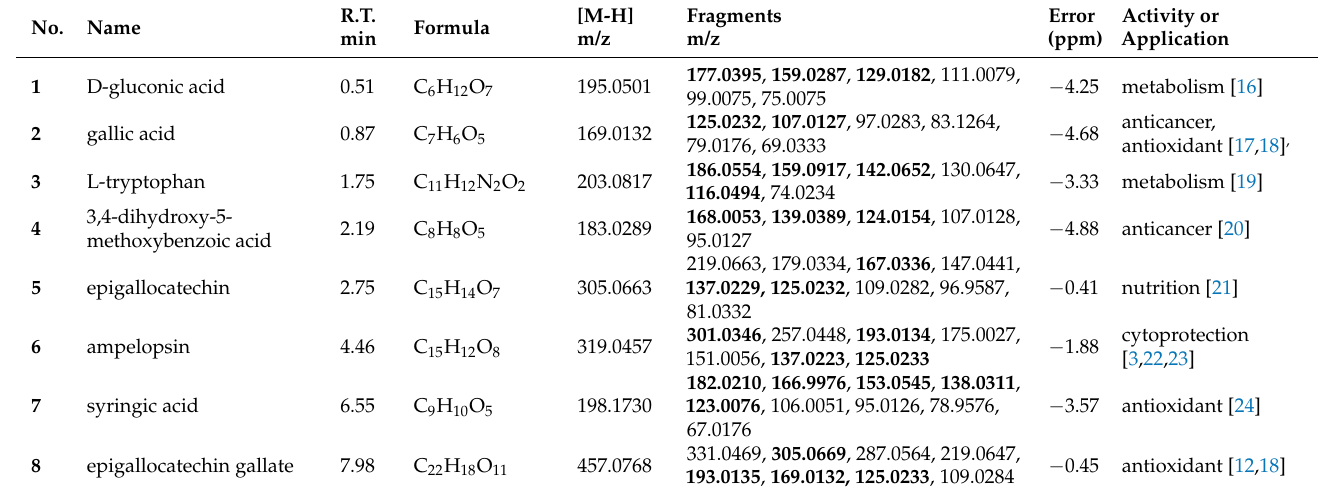
Figure 2. The total ion chromatogram (TIC) of vine tea in the UPLC-Q-Orbitrap-MS analysis. Table 1. The main experimental results of 36 putatively identified bioactive compounds.